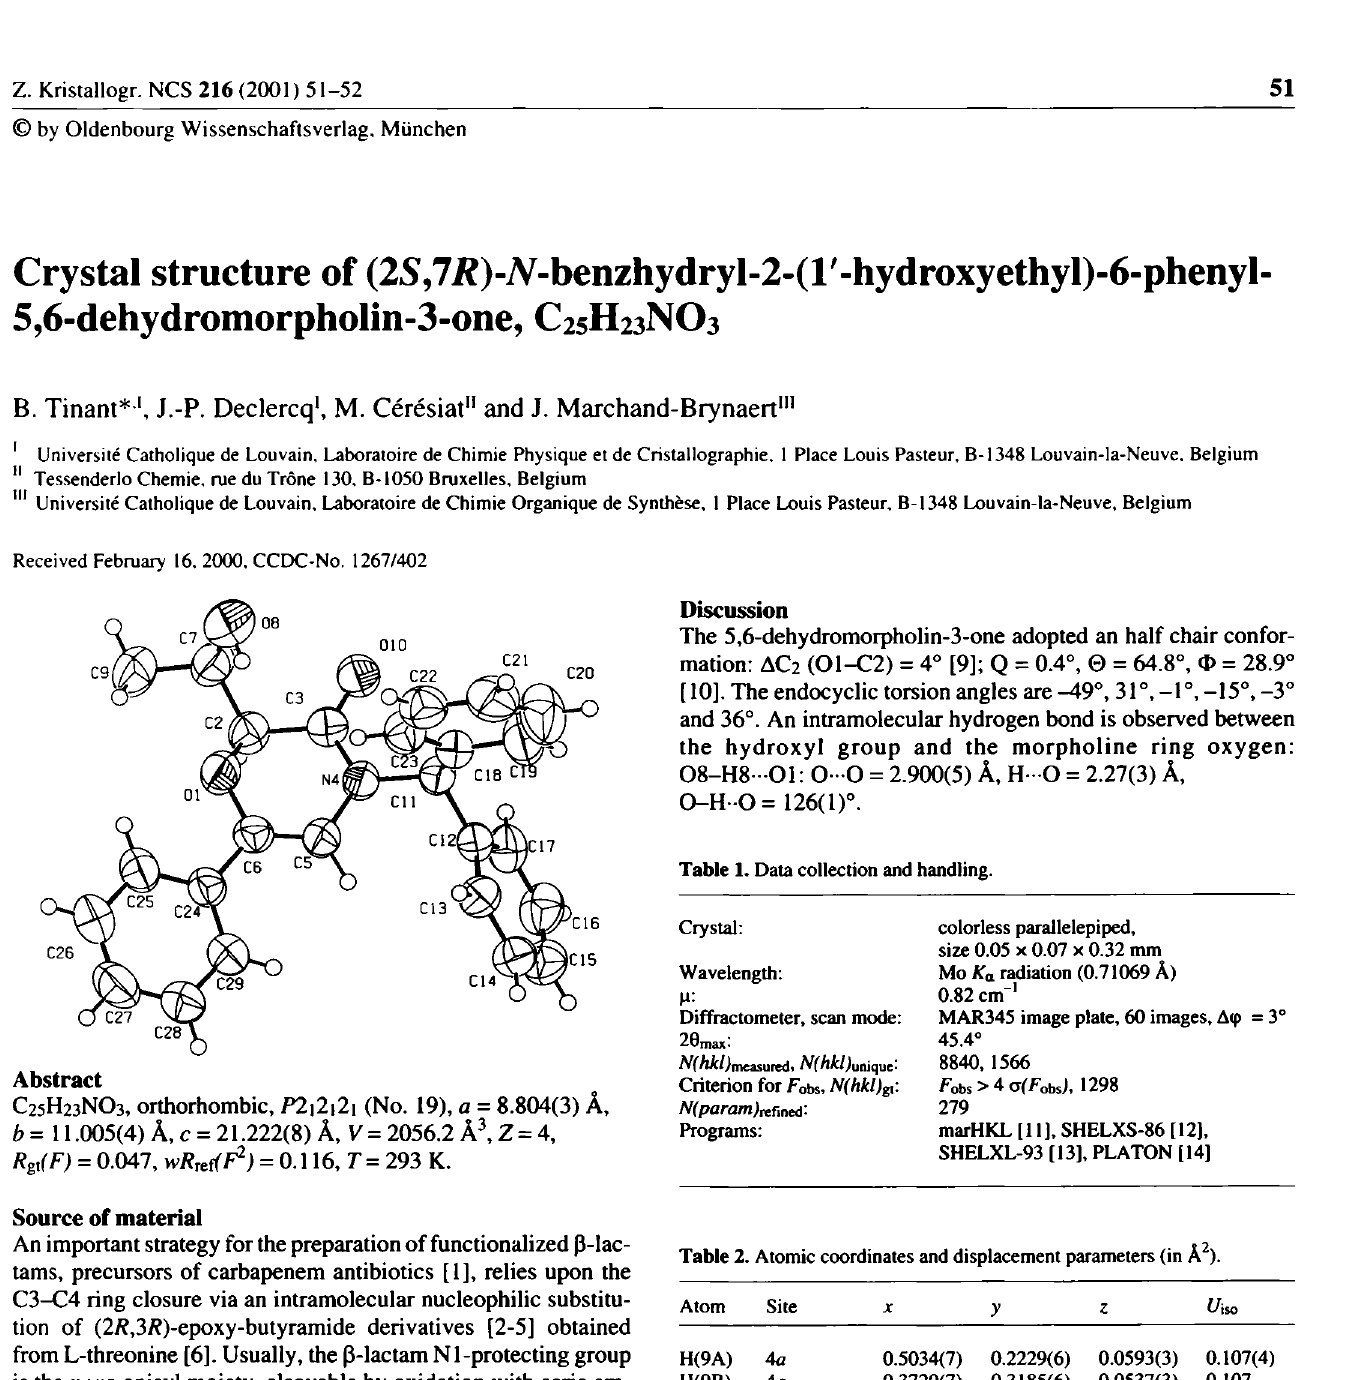
Table 2. Atomic coordinates and displacement parameters (in Ä 2